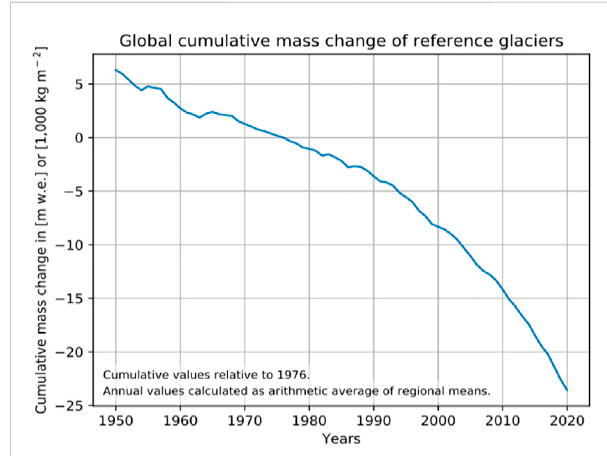
FIGURE 3 Variation in the cumulative mass of reference glaciers. The value is expressed as a meter water equivalent (mwe) compared to 1976. Source: World Glacier Monitoring Service